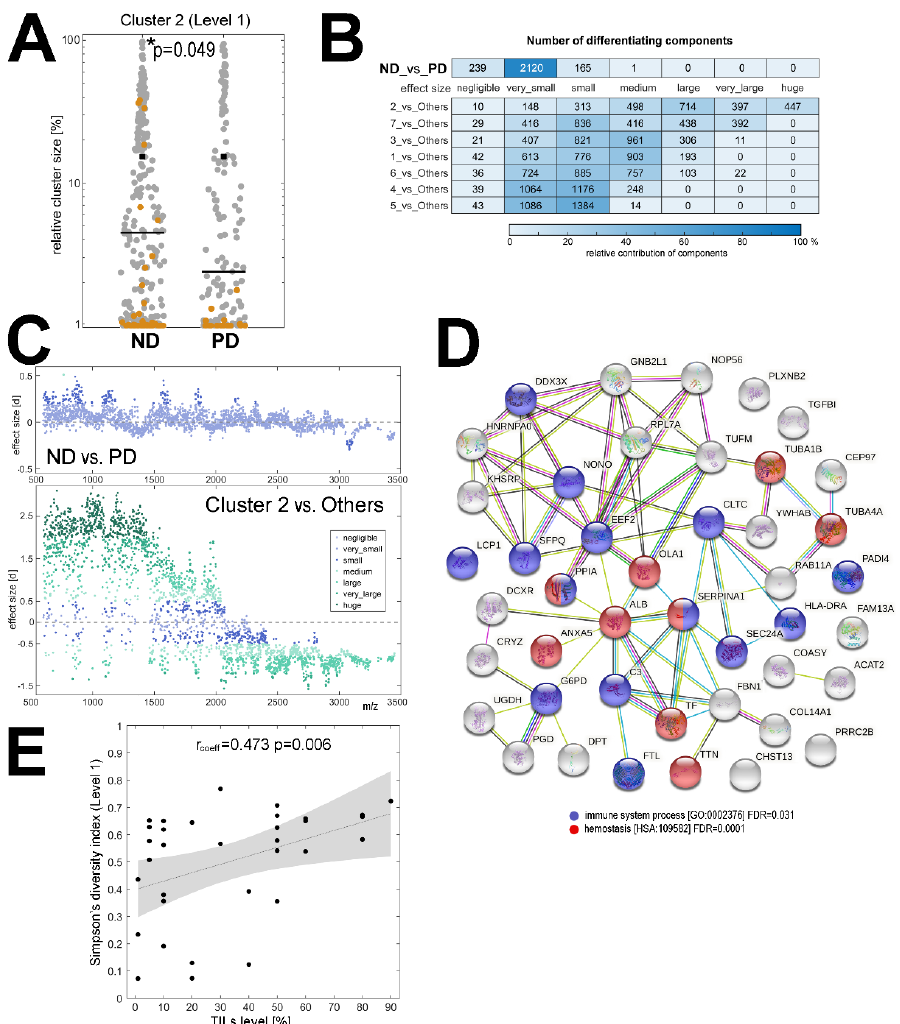
Figure 2. Components that differentiated samples of patients with a different outcome. Panel ( A )— the relative contribution [%] of cluster #2 in the cancer ROI of samples from the ND and PD groups (cluster #2 is marked in brown, all other clusters are shown in grey). * p < 0.05 is marked with asterisks. Panel ( B )—the number of spectral components with a different Cohen’s [d] effect size between the ND and PD groups as well as between a specific cluster (7 clusters from the first level of segmentation) and spectra from all other clusters together. Panel ( C )—spectral components that had a different abundance between the ND and the PD groups (upper graph) and between cluster #2 and all other clusters (bottom graph); the graphs illustrate the molecular size ( m/z ) and the significance of the differences ([d] effect size; positive and negative values reflect the relative upregulation and downregulation). Panel ( D )—the network of interactions between 45 proteins, the tryptic fragments of which were putatively identified as spectral components with different abundance between the ND and PD groups; interaction between proteins and over-represented biological functions associated with these proteins according to an analysis using the STRING toolbox [38]. Panel ( E )—correlation between the level of tumor-infiltrating lymphocytes (TILs; shown as a percentage of the cancer area) and ITH revealed by MSI (Simpson’s diversity index at level 1 of image segmentation); the image shows the regression line with 95% confidence